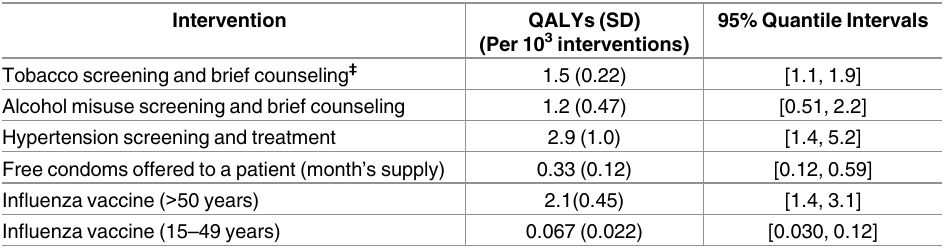
Table 1. QALYs/10 3 -interventions as calculated by Monte Carlo